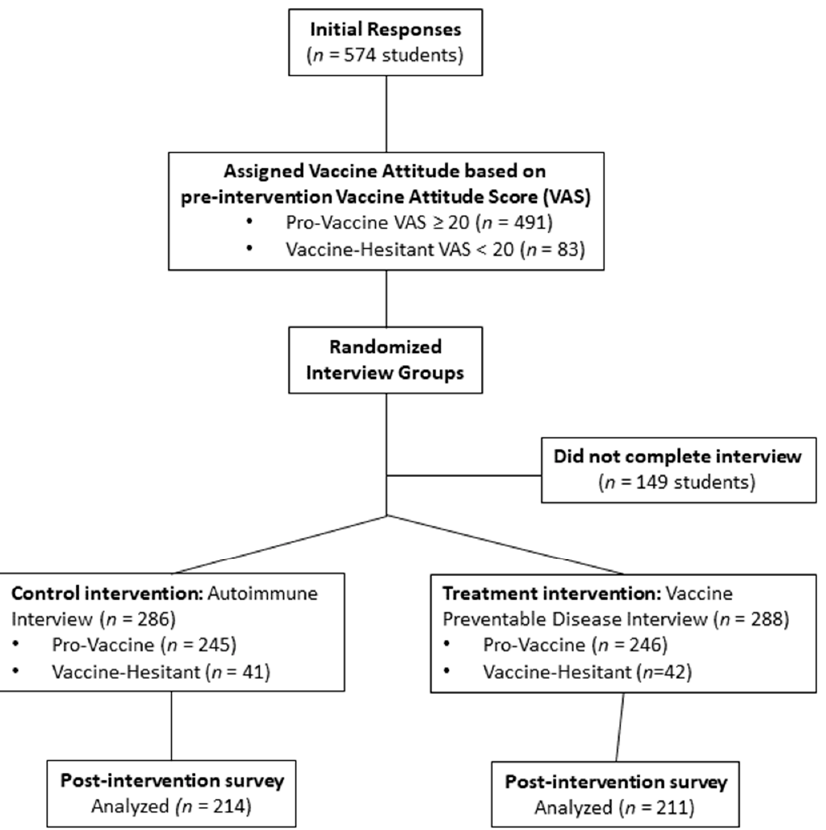
Figure 1. Participant flow through the randomized treatment. Table 1. Baseline characteristics of the participating classes ( n = 425).